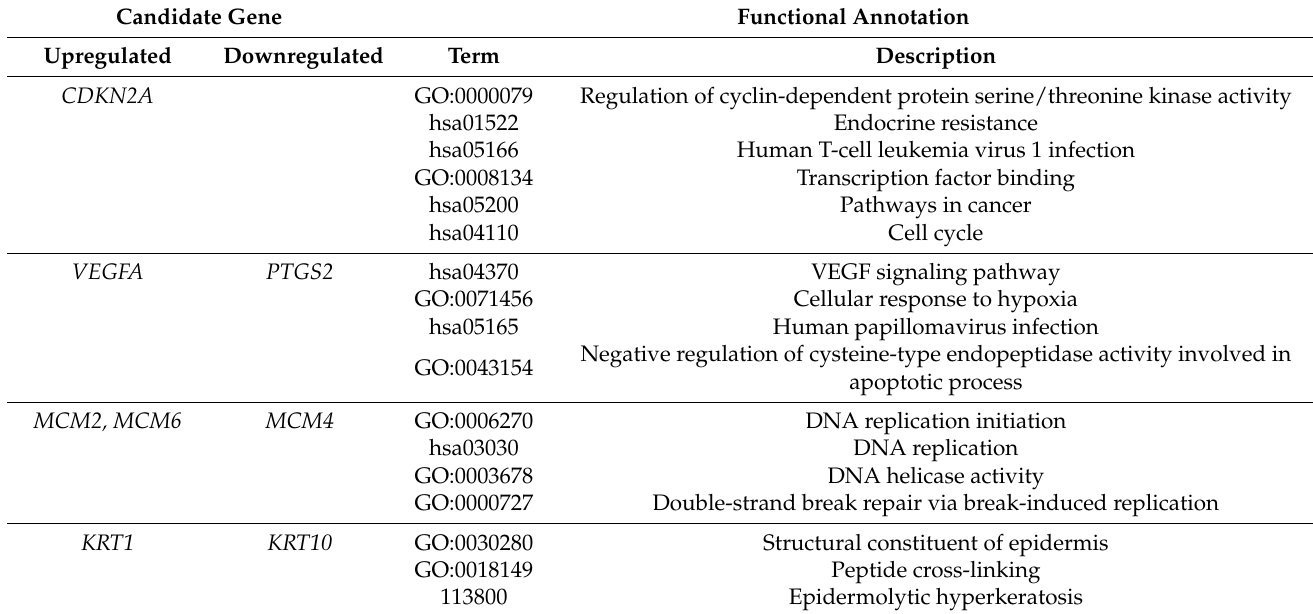
Table 3. The expression regulation of candidate genes and their functional